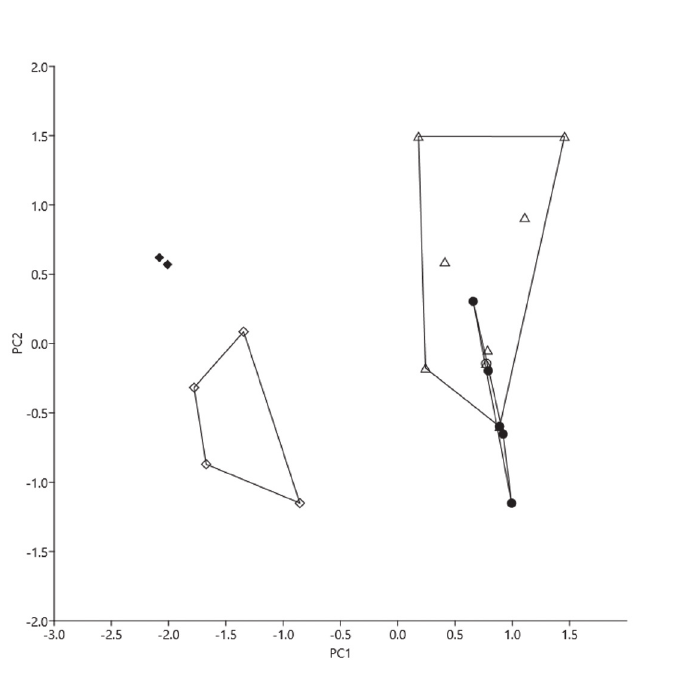
Fig. 7. Scatterplot of PC2 against PC1 for a PCA on 10 meristics (n = 22) of E. cf . brazzai (Pellegrin, 1901): ‘Kisangani region’ 2 ( ◊ ), Ituri 3 ( ♦ ) and ‘Kisangani region’ 3 ( ∆ ). Also shown are the type specimens examined of E. brazzai (Pellegrin, 1901) ( ○ ) and E. tshopoensis (De Vos, 1991)